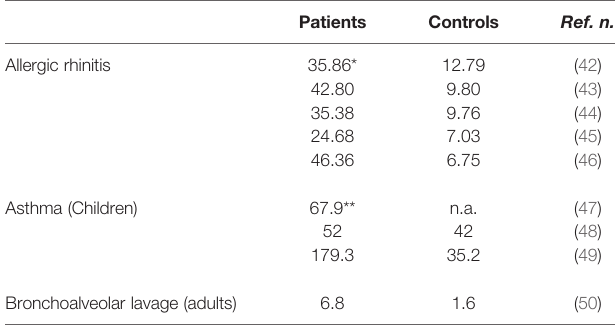
TABLE 1 | sHLA-G plasma levels in Allergic Rhinitis and Asthma. Patients Controls Ref.